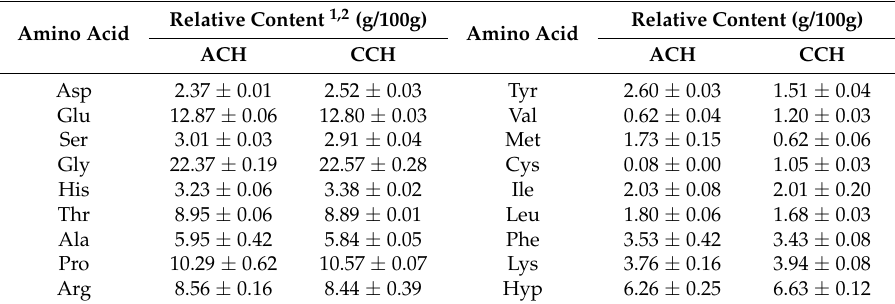
Table 2. Amino acid compositions of gelatin from silver carp